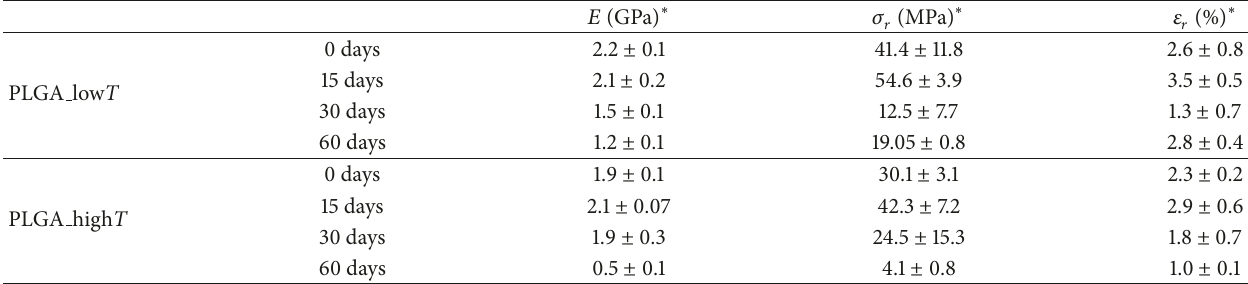
Table 2: Mechanical properties of injection molded PLGA 85/15 plates (mean ± standard deviation, 𝑛 = 3): flexural stiffness, 𝐸 ; flexural strength, 𝜎 𝑟 ; and maximum flexural strain, 𝜀 𝑟 ( ∗ 𝑝 < 0.05)